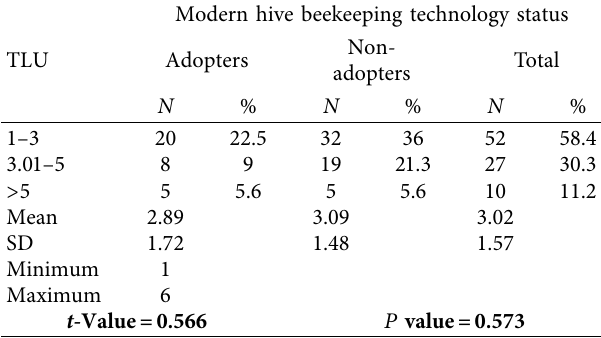
Table 7: Distribution of household respondents by land size. Land size (ha)